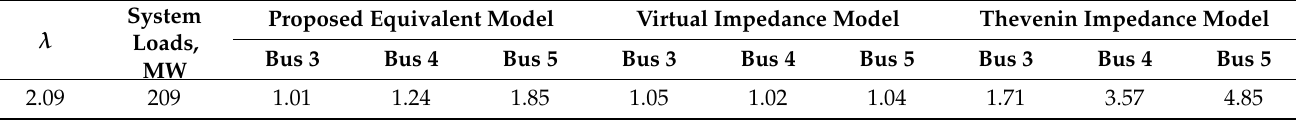
Table 4. Voltage stability local indices for the radial five-bus system with G 2 and l 24 out of operation when λ = 2.09. System Proposed Equivalent Model Virtual Impedance Model Thevenin Impedance λ Loads, MW